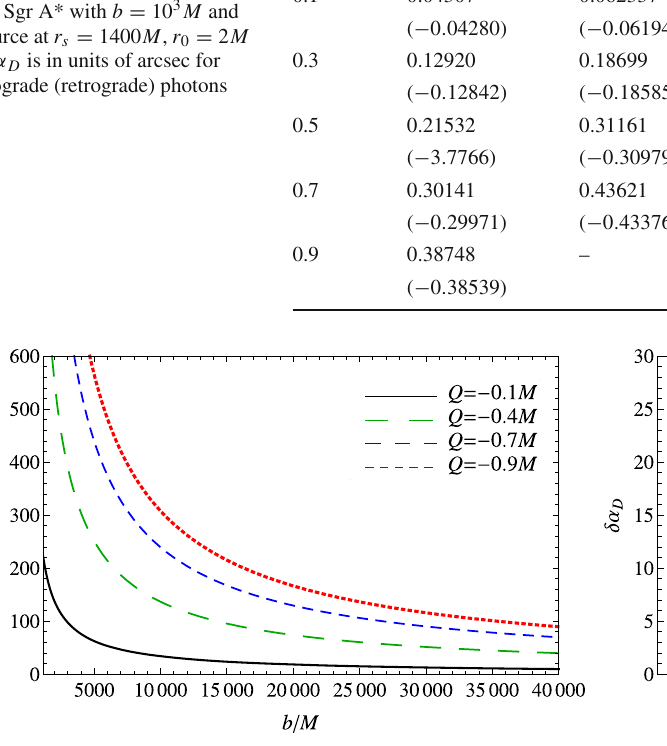
Table 4 The corrections in the deflection angle δα D from the nonrotating Horndeski gravity black hole δα D = α D | NR − α D for Sgr A* with b = 10 3 M and